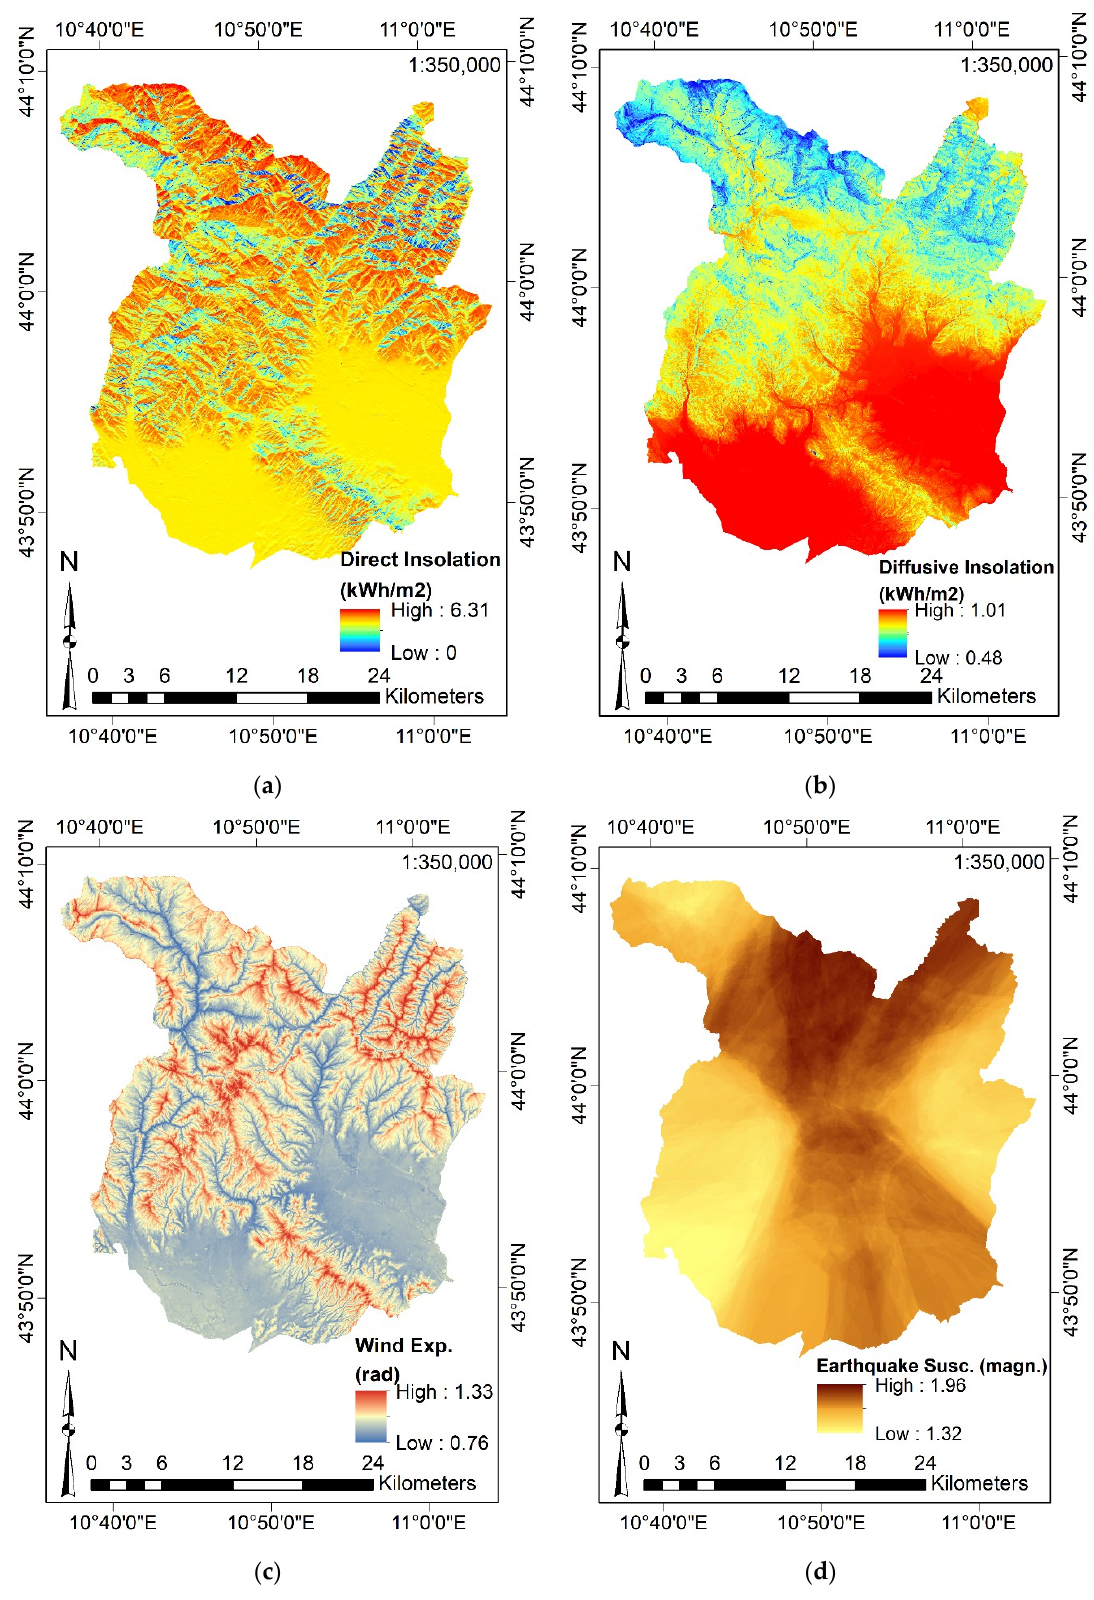
Figure A7. Input features—environmental-based computed factors: ( a ) Direct Yearly Solar Radiation; ( b ) Diffusive Yearly Solar Radiation; ( c ) WE; ( d ) Earthquake susceptibility.